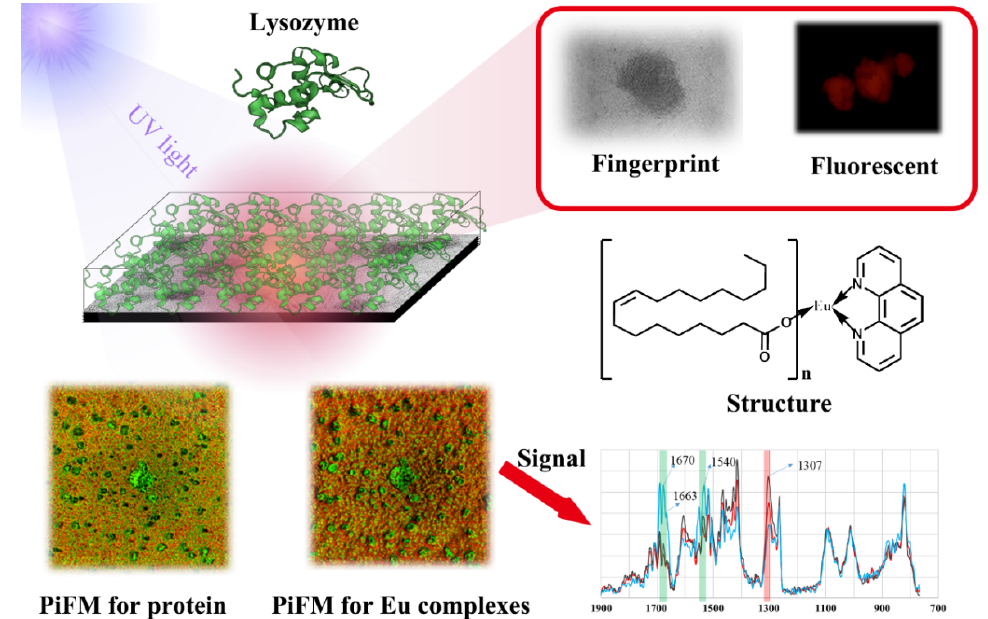
3+ complexes implanted under